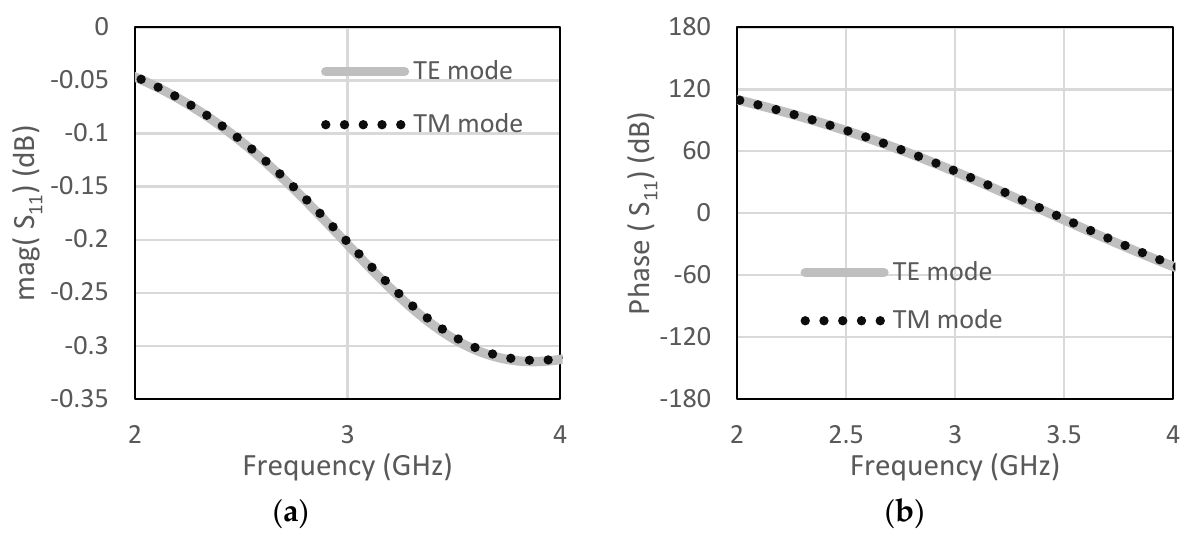
Figure 2. Circular type of patch ( a ) magnitude of S 11 ( b ) phase of S 11 .